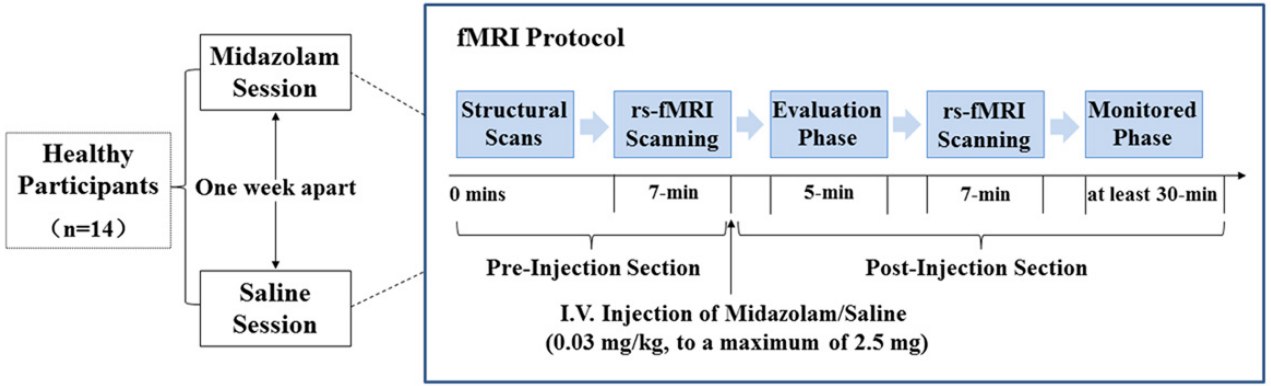
Figure 1. Study procedures of the study. Abbreviations: rs-fMRI, resting-state functional magnetic resonance imaging; I.V., intravenous injection.